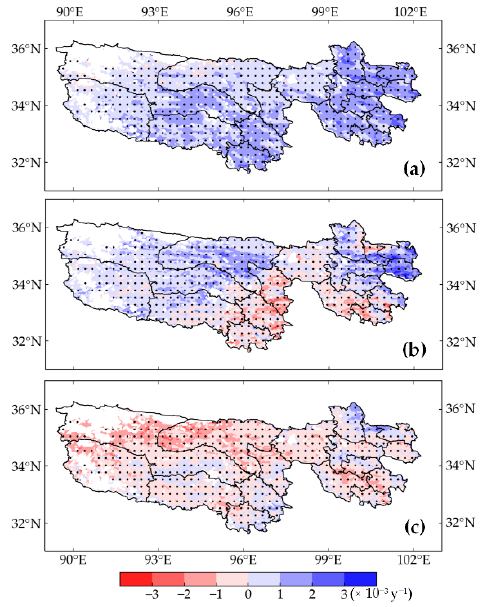
Figure 11. Spatial pattern of NDVI trends from ( a ) 1982–2018, ( b ) 1982–1998, and ( c ) 1998–2018 in the TRHR. The black solid dots refer to grids with 95% confidence.